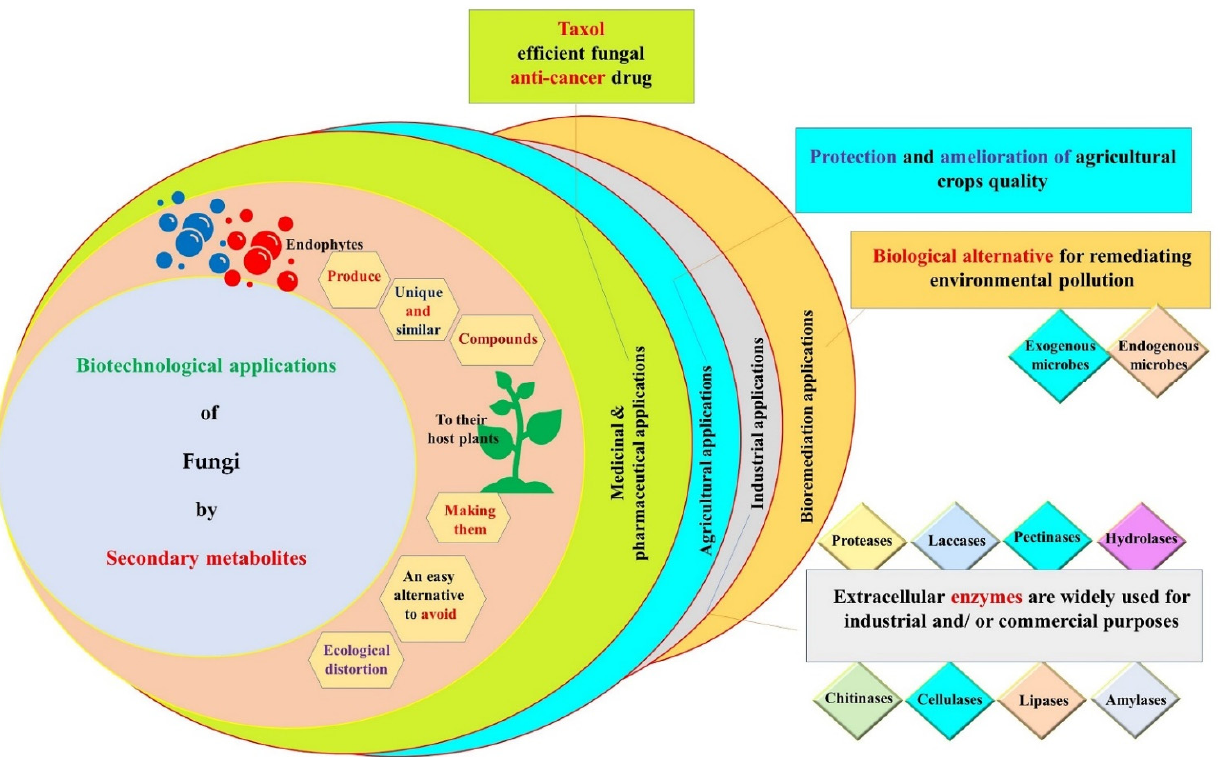
Figure 2. Biotechnological applications of secondary metabolites and enzymes produced by endophytic fungi.